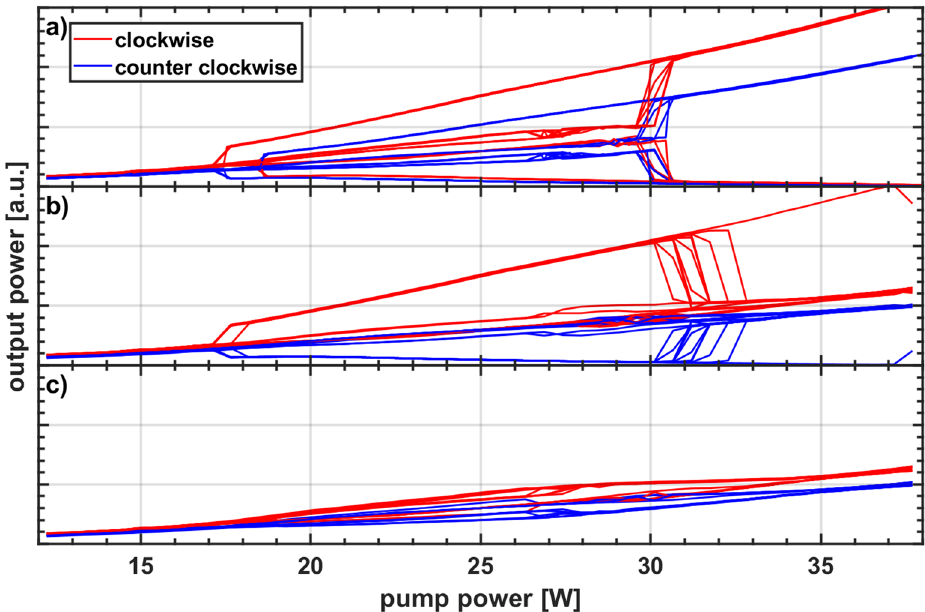
Figure 7. Superimposed output power traces for 30 power cycles of the cavity containing 1 km low loss fiber separated in switching events during ( a ) increase and ( b ) decrease of the pump power, or ( c ) without switching to unidirectional